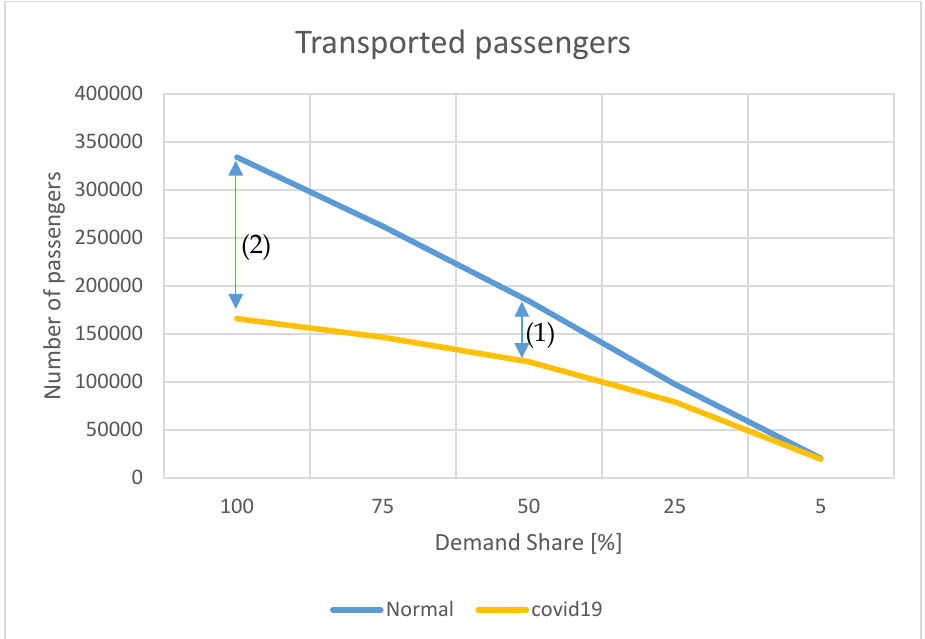
Figure 2. Transported passengers based on the actual given demand